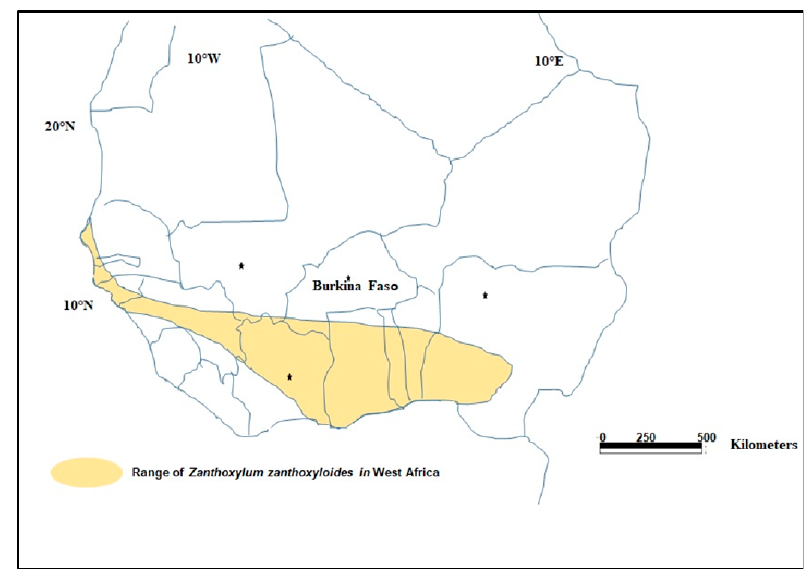
Figure 1. Distribution of Zanthoxylum zanthoxyloides in West Africa (adapted from Bonnet and Arbonnier [9]).